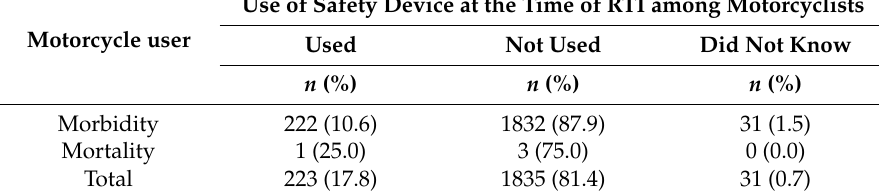
Figure 4. Injury severity index related to road user in RTI morbidity. Table 3. Use of safety device at the time of RTI among motorcyclists. Table 3. Use of safety device at the time of RTI among motorcyclists.